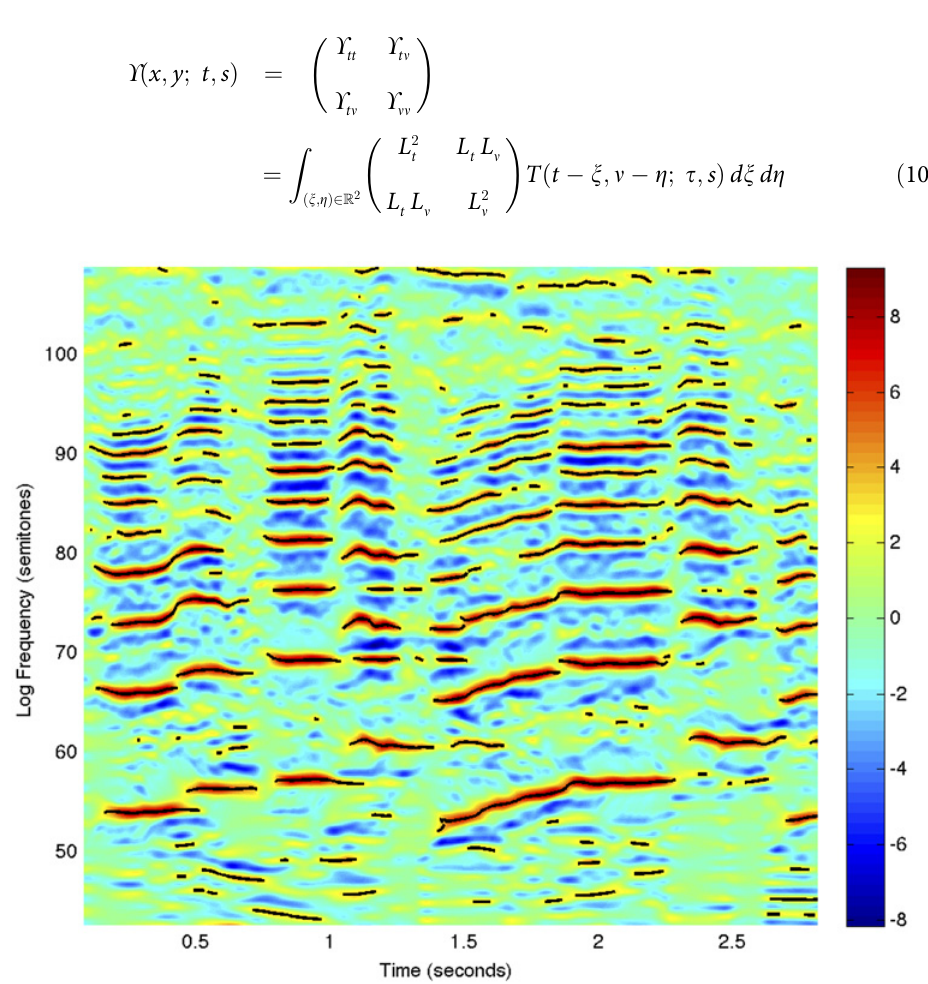
Fig 14. Spectro-temporal curves that make explicit how the frequencies of partial tones vary over time , computed as the zero-crossing curves of the logspectral derivative @ ν ( − D νν log j S j ) = 0 that satisfy @ νν ( − D νν log j S j ) < 0 and which thereby become continuous curves over time (drawn in black, thresholded on − D νν log j S j (cid:5) C for C = 3 and overlaid on − D νν log j S j ). (Horizontal dimension: time t , Vertical dimension: logarithmic frequency ν